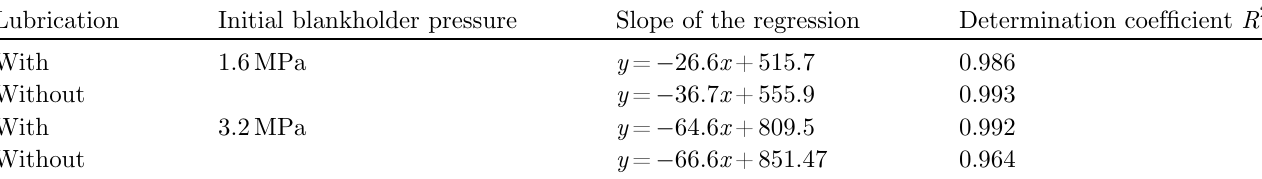
Table 5. Regression analysis of variation of the drawing clearance in the case of using steel